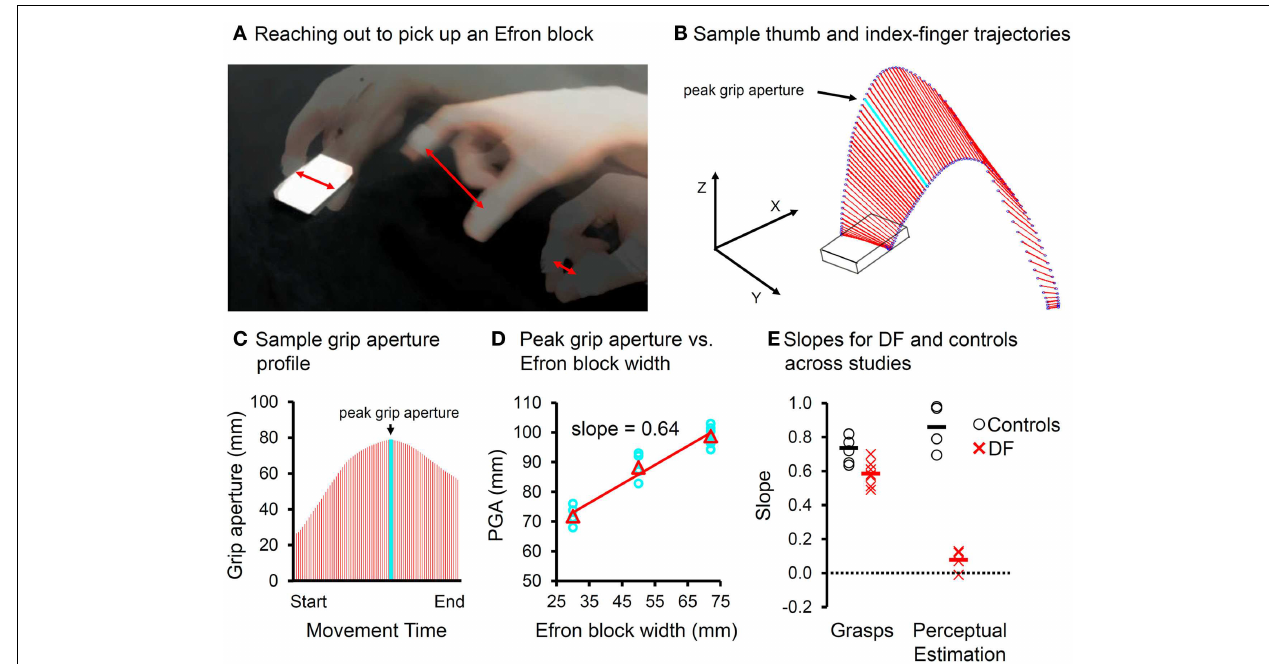
estimation for both the controls (open circles) and DF (X’s) across studies in which Efron blocks were used, the visual conditions were “ecological” (i.e., online visual feedback was available), and the controls were gender-matched and age-appropriate for DF. Although DF scales her grasp to the width of the Efron blocks, her slopes are significantly shallower than those of the controls, using either independent or paired-samples variants of the t -test ( p max < 0.04).The slopes of DF’s manual estimations are essentially zero and clearly different from those of the controls ( p max < 6 × 10 − 3 ). Critically, the difference in slopes between the grasping and manual estimation tasks falls well-outside of the range of the controls ( p max < 5 × 10 − 3 ). In other words, across a number of comparable studies of DF’s grasping and perceptual estimation ability, her performance when grasping Efron blocks is sharply dissociated from her performance when perceptually estimating their